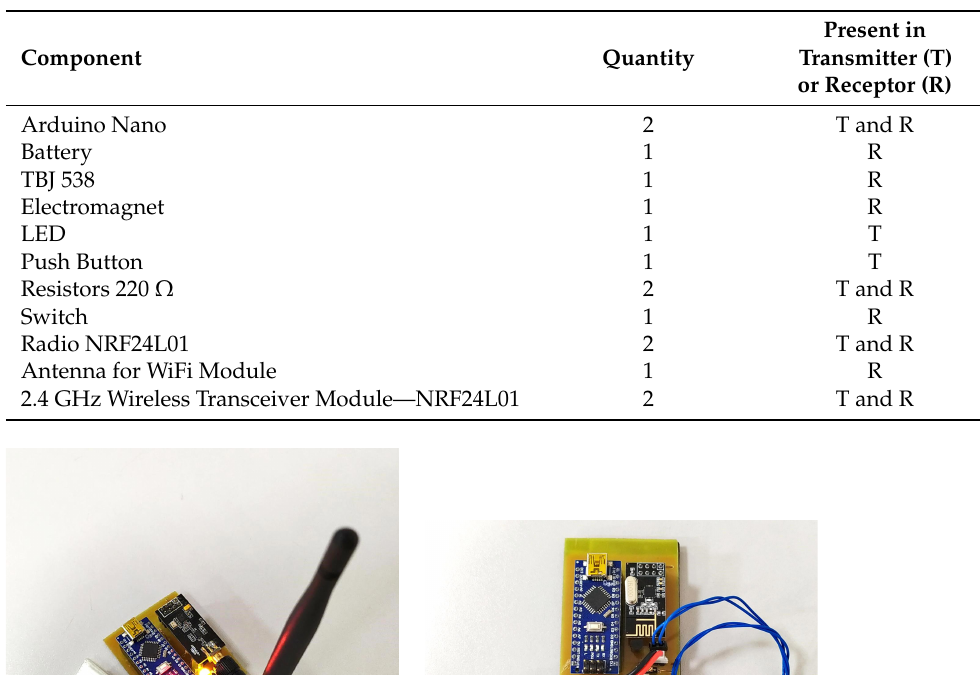
Figure 8. The experimental setup. Table 1. Table of components used in transmitter and receptor.